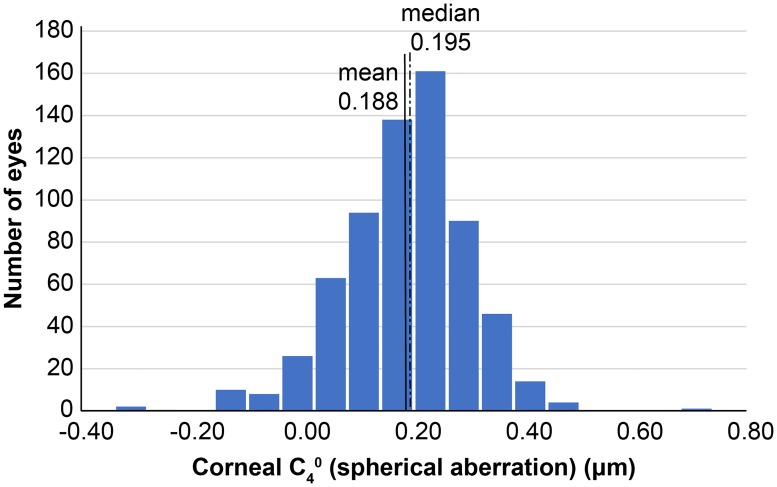
Distribution of corneal spherical aberration (SA; C40).The mean corneal SA was 0.188 ± 0.095 μm, and is represented by the thick solid line. The median value was 0.195 μm, and is represented by the dotted line.